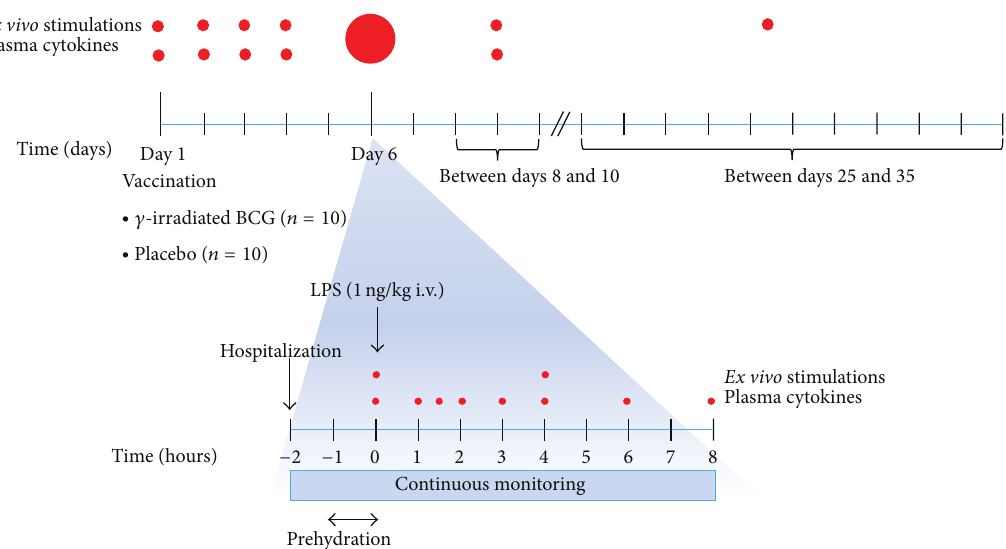
Figure 1: Experimental design. BCG: Bacille Calmette-Gu´erin; LPS: